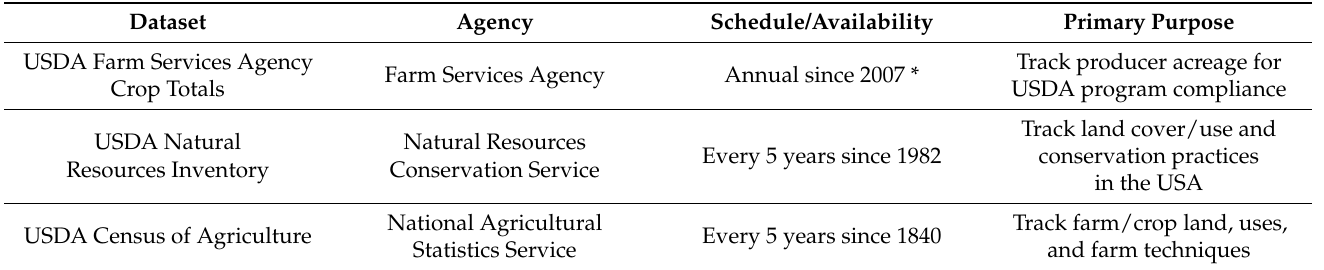
Table 1. USDA datasets used in the study with the agency, their publication schedule, and